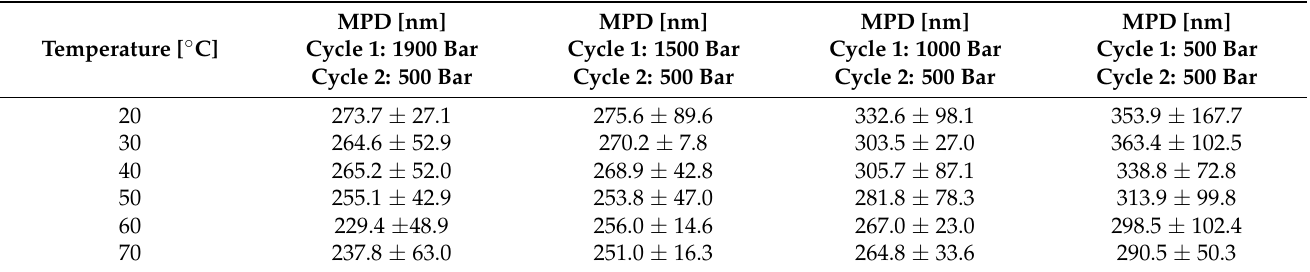
Table 4. Mean particle diameter (MPD) achieved by the two-cycle process at different operating pressures for each cycle and different emulsion temperatures at the inlet of the homogenizer.